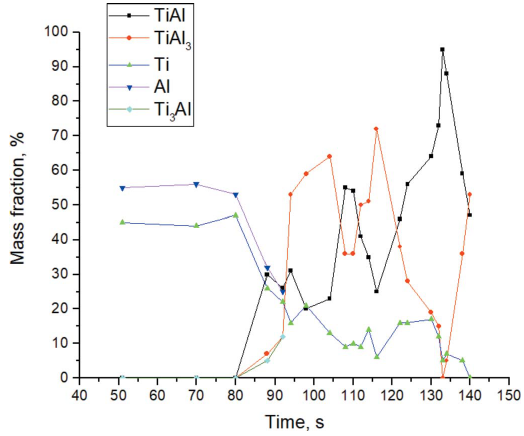
Figure 21 Relative content of in situ fixed phases in the process of high-temperature